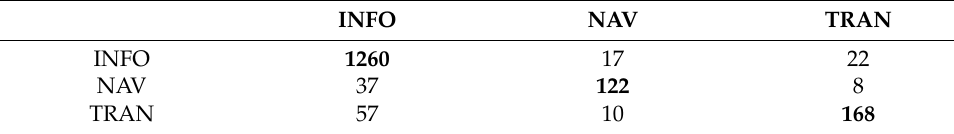
Table 9. Confusion matrix for the proposed U-IntentCapsNet model.